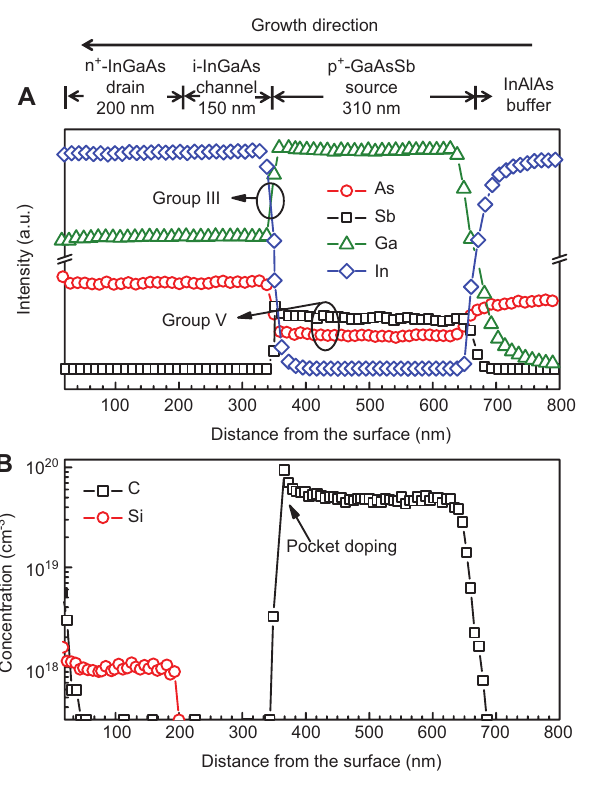
Figure 36 (A) Dynamic SIMS depth profiles of Ga, In, As, and Sb of the GaAs Sb /In Ga As TFET structure after temperature 0.35 0.65 0.7 0.3 cycle. (B) Doping concentration profiles of C in the source and Si in